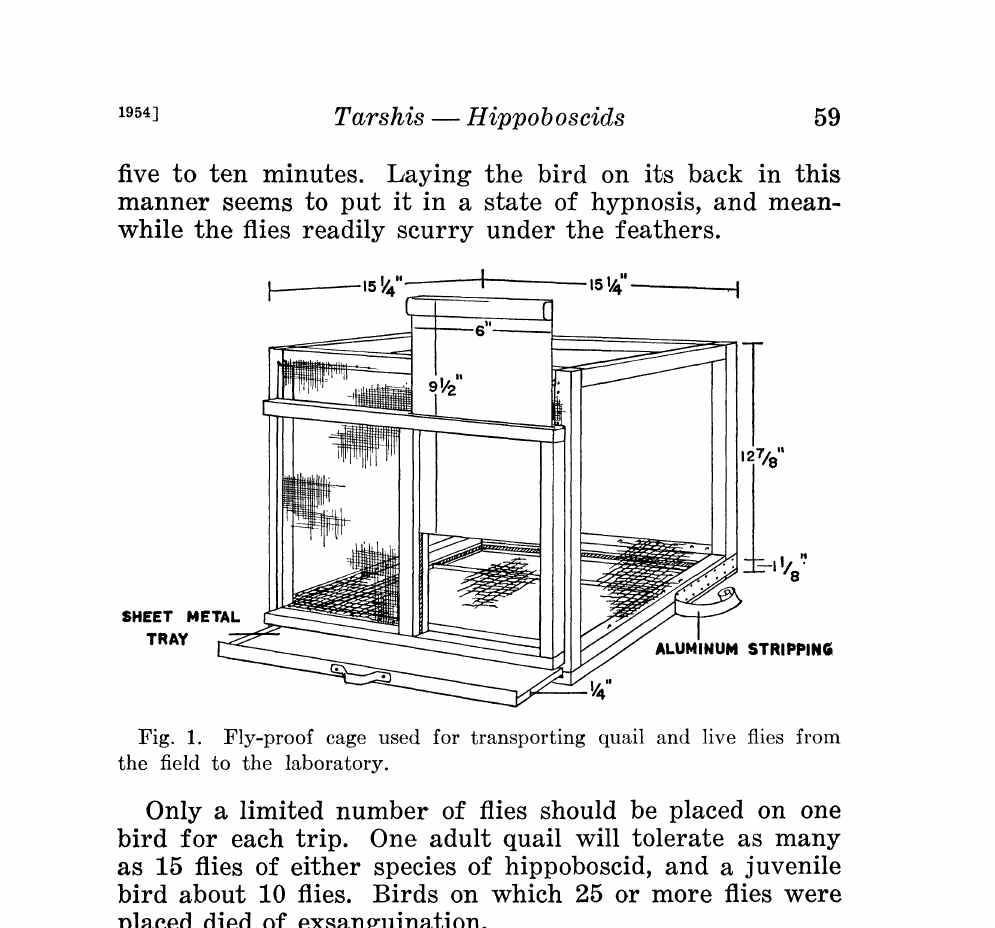
Fig. 1. Fly-proof cage used for transporting quail and live flies from the field to the